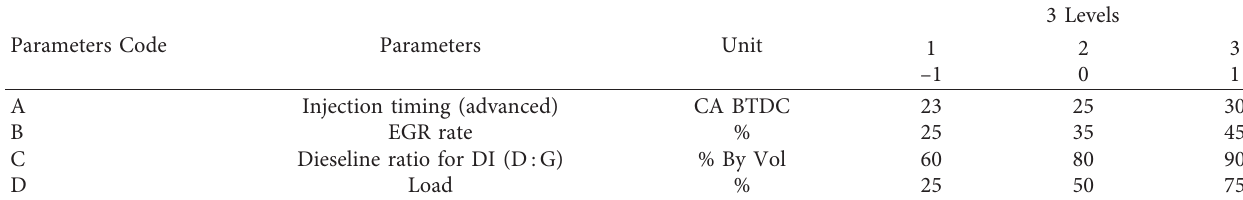
Table 3: Control factors and their